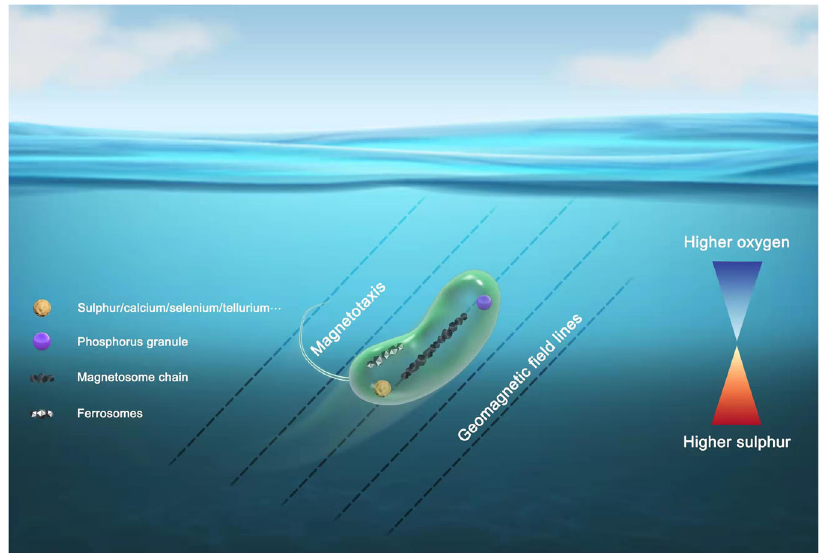
Fig. 4 Magnetotaxis, combined with chemotaxis and aerotaxis, allows MTB to ef fi ciently locate and maintain an optimal position for survival and growth in habitats with vertical redox concentration gradients in water columns and sediments around an oxic – anoxic interface (OAI). MTB are widely distributed in aquatic environments from marine to freshwater ecosystems and are thought to play important roles in the cycling of various elements (e.g., Fe, C, N, S, P, and some heavy metals, such as tellurium and